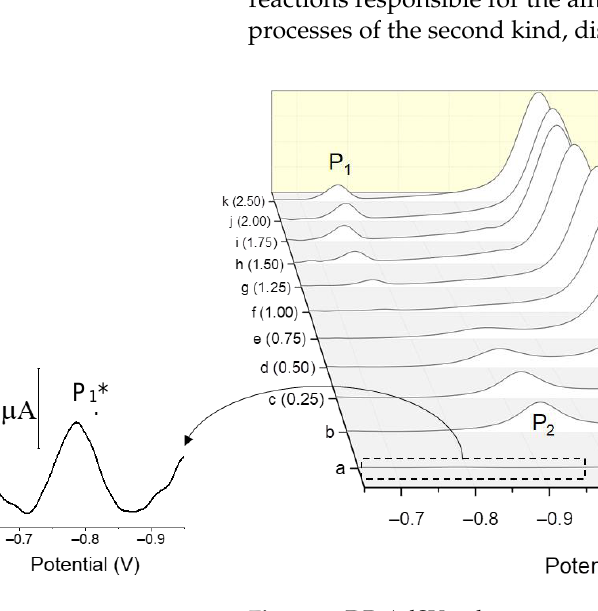
Figure 6. DP-AdSV voltammograms recorded in a solution containing: (a) 10 nM of Ge and 1mM of catechol, (b) 10 nM of Ge, 1 mM of catechol and 1 mM of V(IV). Voltammograms (c–k) were recorded for solution (b) spiked with increasing amounts of a 0.2 M solution of HEDTA in order to obtain the following final concentrations of HEDTA: (c) 0.25 mM, (d) 0.5 mM, (e) 0.75 mM, (f) 1.0 mM, (g) 1.25 mM, (h) 1.5 mM, (i) 1.75 mM, (j) 2.0 mM and (k) 2.50 mM. The values provided in brackets represent the V(IV)/HEDTA ratio. Supporting electrolyte: 0.05 M acetate buffer (pH = 4.4). Instrumental parameters: E acc = − 0.2 V, t acc = 80 s. Reprinted with permission from ref.